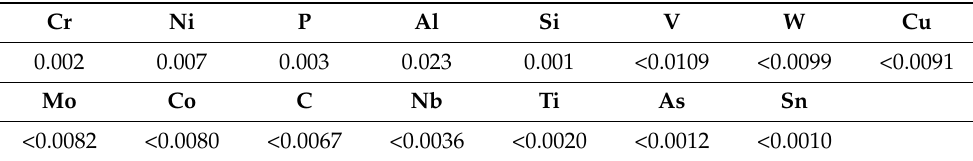
Table 1. Chemical composition of Fe (G379) and detection limits of impurities using SS-OES and ICP-OES, in